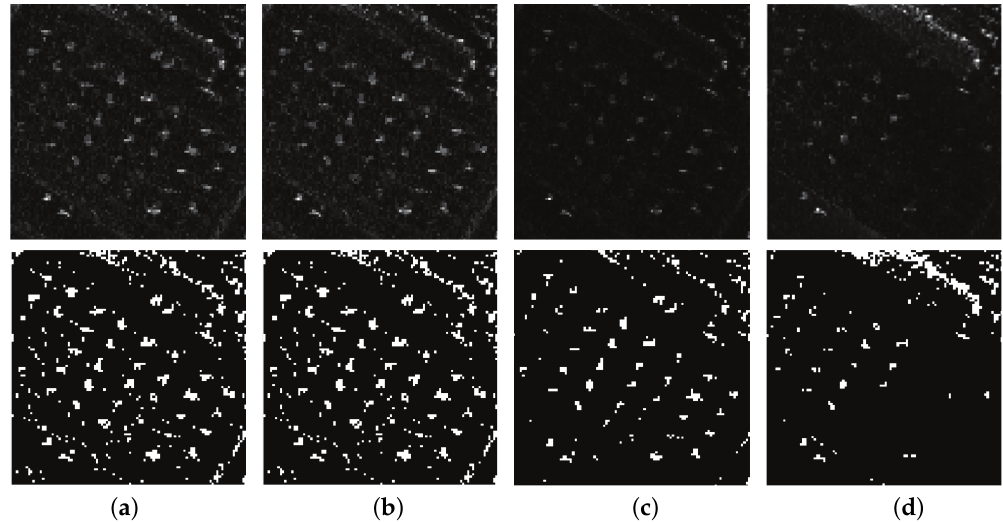
Figure 11. Detection results of AVIRIS data for different algorithms: ( a ) LS-RXD; ( b ) R-LS-RXD; ( c ) Recursive background Suppression local summation RXD (R-BS-LS-RXD); ( d ) Causal sliding array window (CSA-RXD).